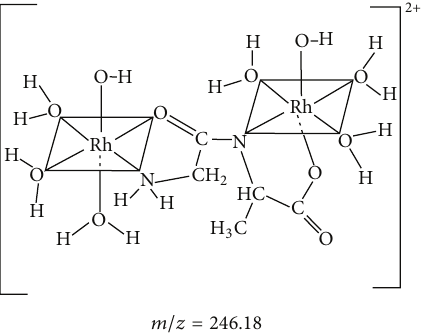
Figure 3: ESI-mass spectrum of the substituted hydroxopentaaquarhodium(III) ion by glycyl-L-alanine.